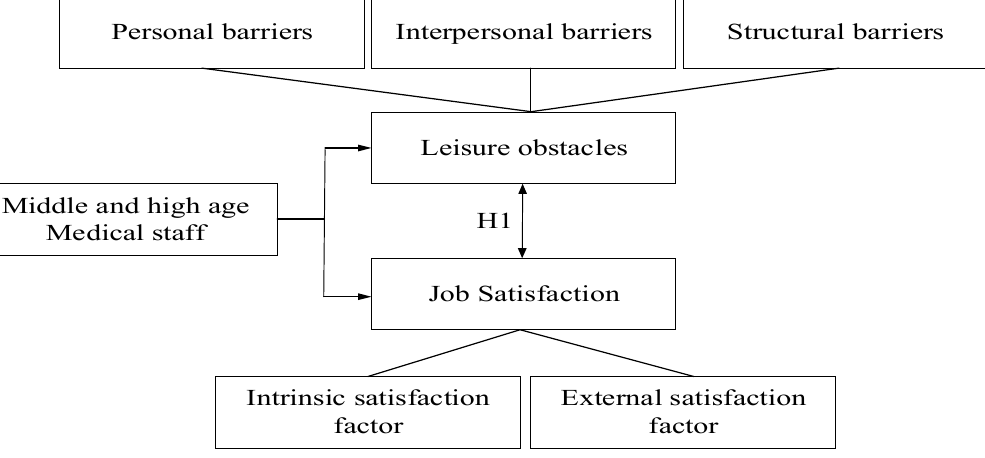
Figure 1. The research structure.